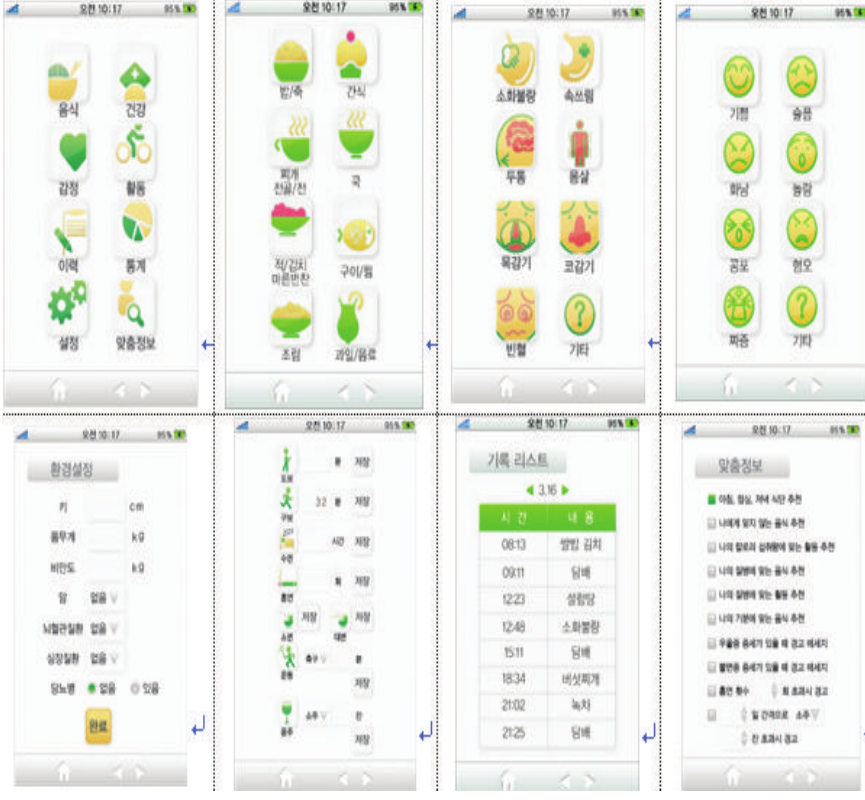
Figure 10: Smartphone application user interface.